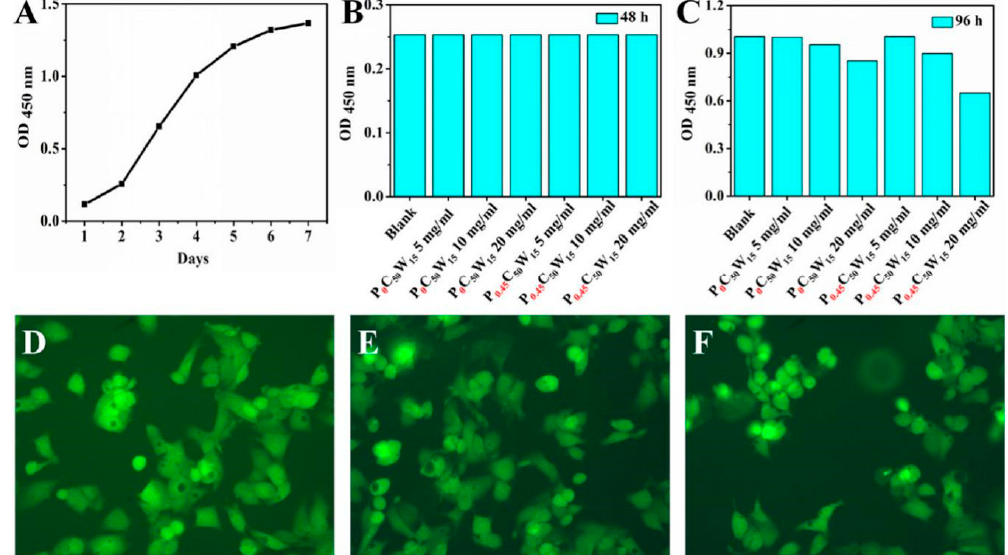
Figure 11. ( A ) Standard growth curves of HpEG2 cells; ( B ) and ( C ) are the effects of different dosages of P 0 C 50 W 15 and P 0.45 C 50 W 15 on HepG2 cells proliferation for 48 h and 96 h respectively; ( D ) the fluorescent micrographs (300×) of HepG2 cell grown under normal condition; ( E ) and ( F ) are fluorescent micrographs of HepG2 cell grown for 48 h with presence of P 0 C 50 W 15 and P 0.45 C 50 W 15 under low dosage (5 mg/mL).